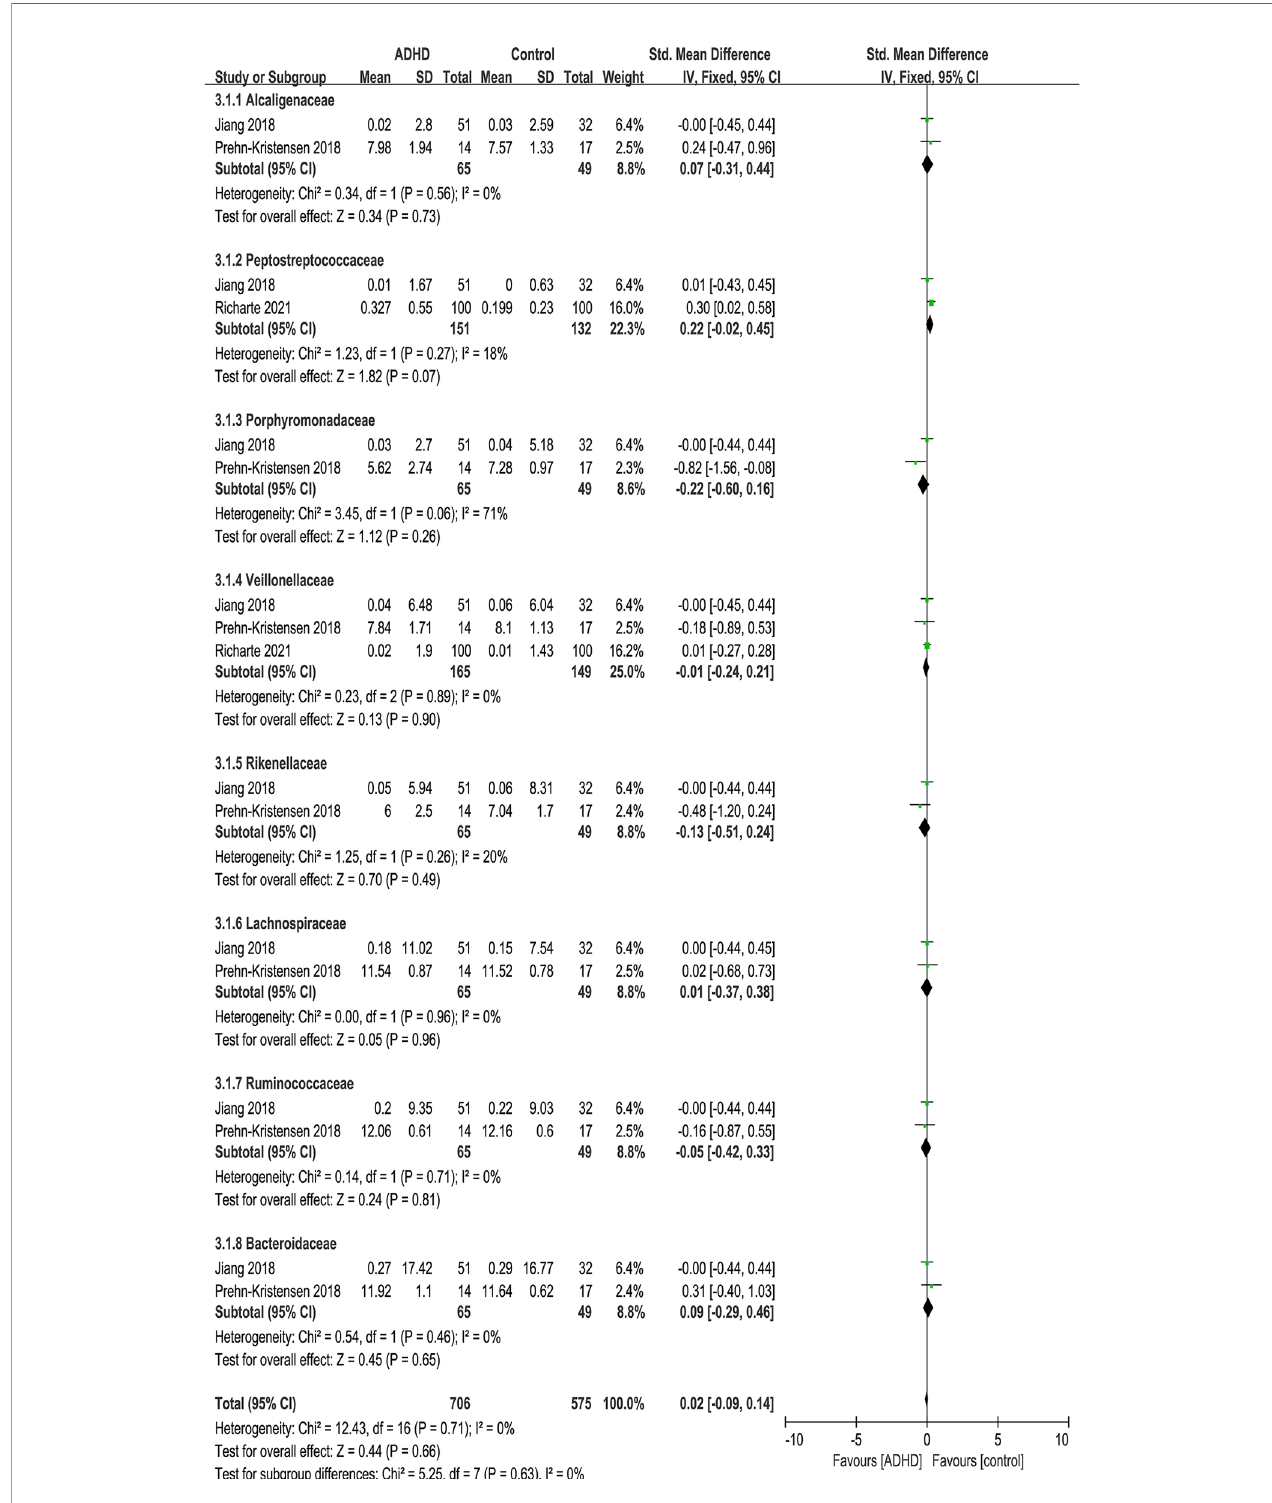
FIGURE 7 | Forest plot of relative abundance of Family in the Gut Microbiota of ADHD Compared with HCs. CI, con fi dence interval; SMD, standardized mean difference.